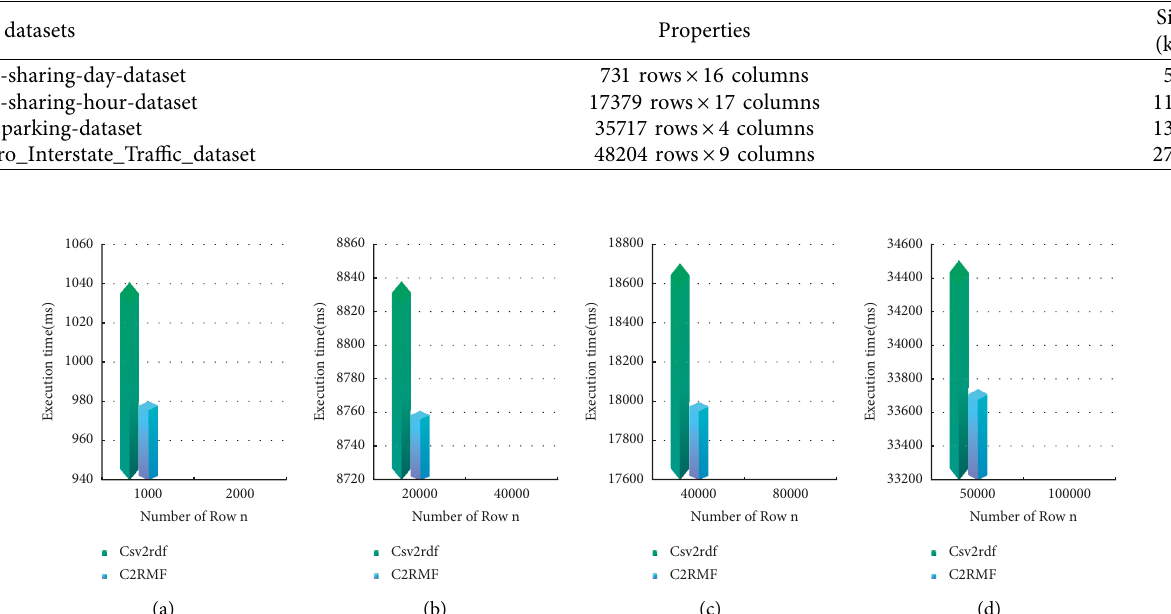
Table 4, the non-functional testing results are listed below: